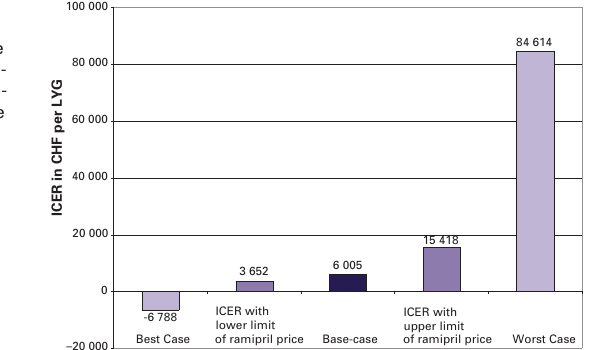
Figure 2 One way sensitivity analysis of the price of ramipril and best- case/worst-case sce- nario analysis in the HOPE population (discounted with 5% per year). ICER: Incremental cost-effectiveness